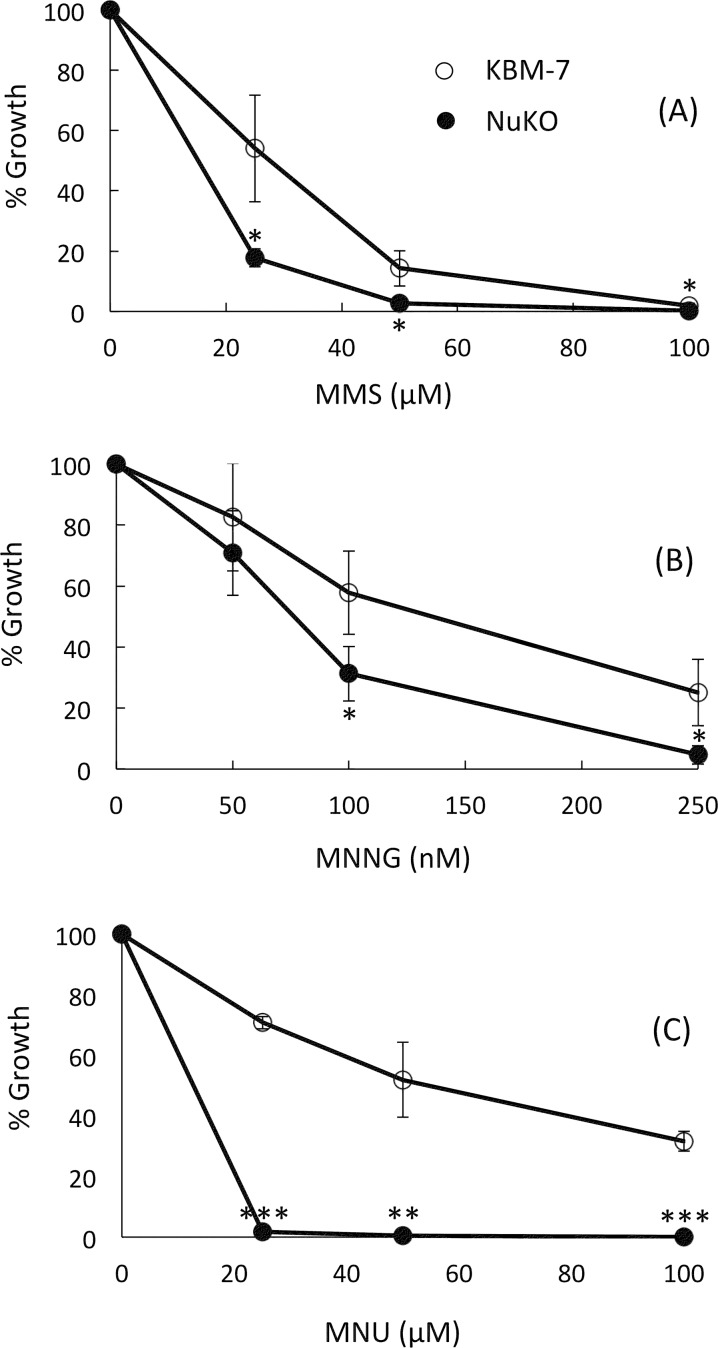
Growth inhibition curves for cells in the presence of (A) methylmethane sulfonate (MMS), (B) N-methyl-N'-nitro-N-nitrosoguanidine (MNNG) and (C) N-methylnitrosourea (MNU). Growth of KBM-7 (open symbols) and KBM-7-NuKO (closed symbols) cells was assessed as described in Materials and Methods. Data are presented as means ± SEM of the results obtained from three independent experiments. When no error bar is shown, the error is smaller than the symbol. Statistical significance was assessed by Student’s two-tailed t-test; *P < 0.05, **P < 0.01, ***P < 0.001 versus WT control.